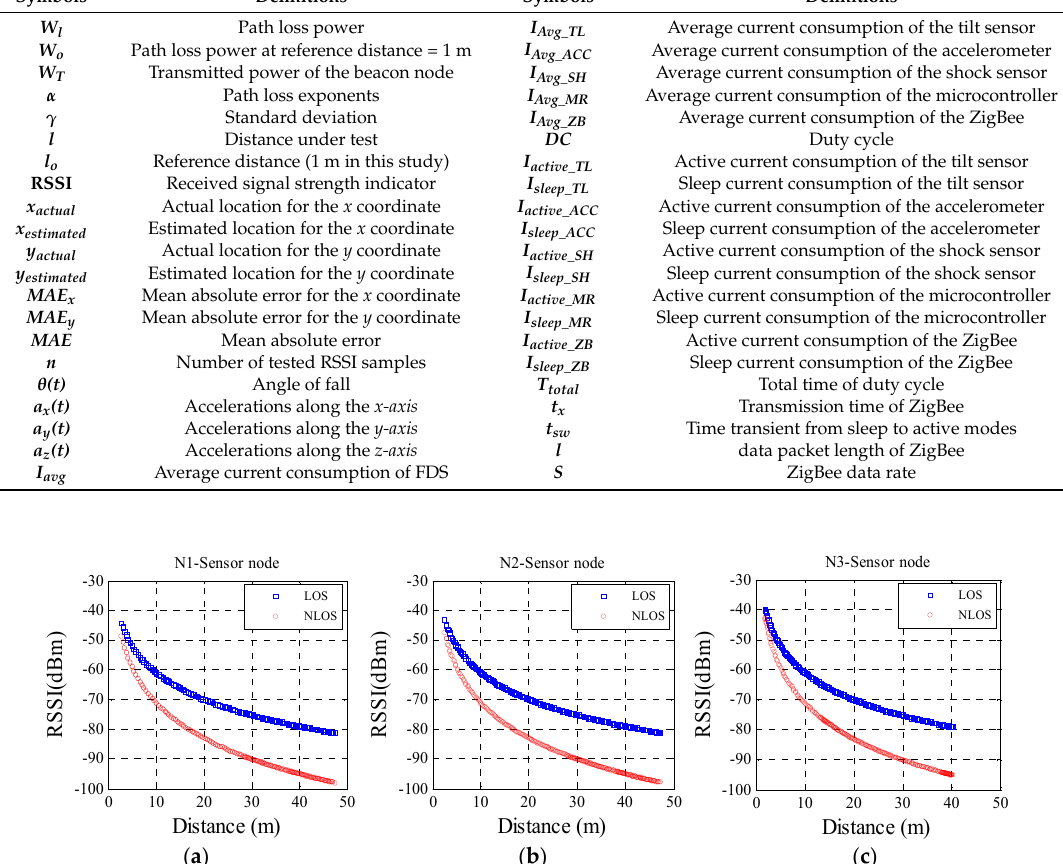
Figure 6. RSSI between beacon nodes and sensor node for LOS and NLOS: ( a ) N1-sensor node, ( b ) N2-sensor node, and ( c ) N3-sensor node.